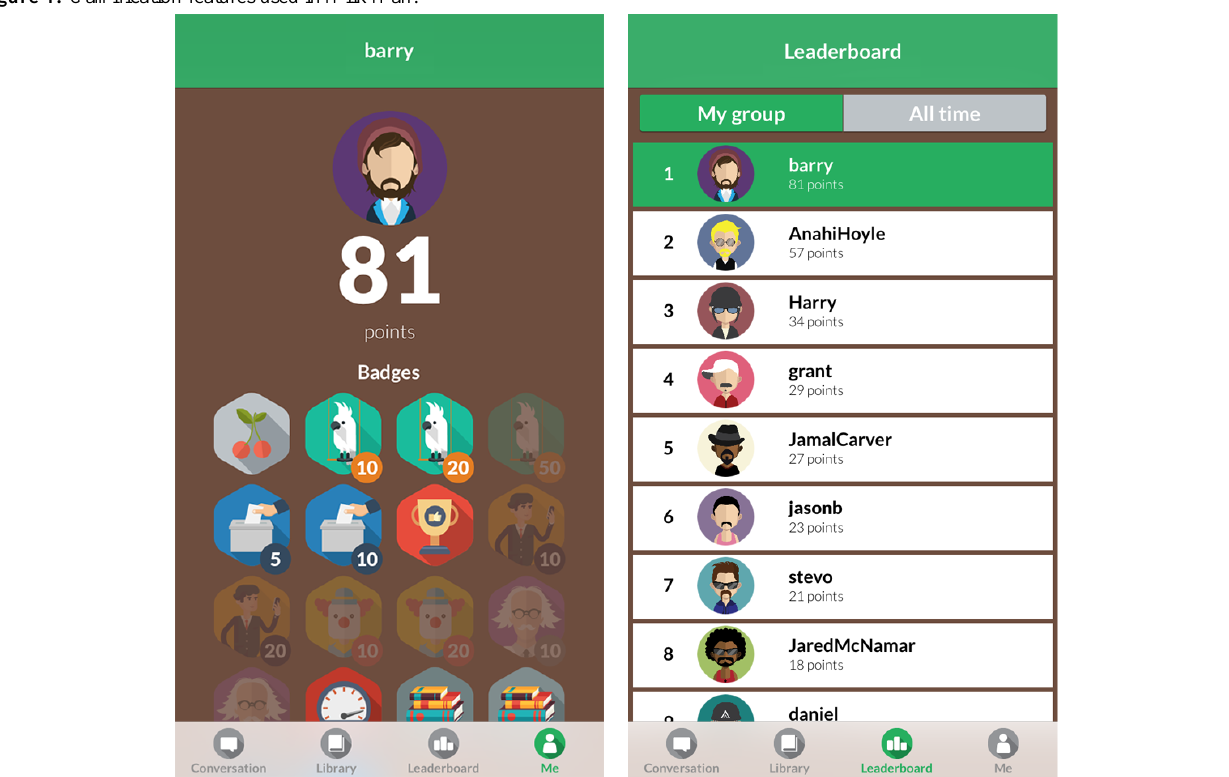
Figure 4. Gamification features used in Milk